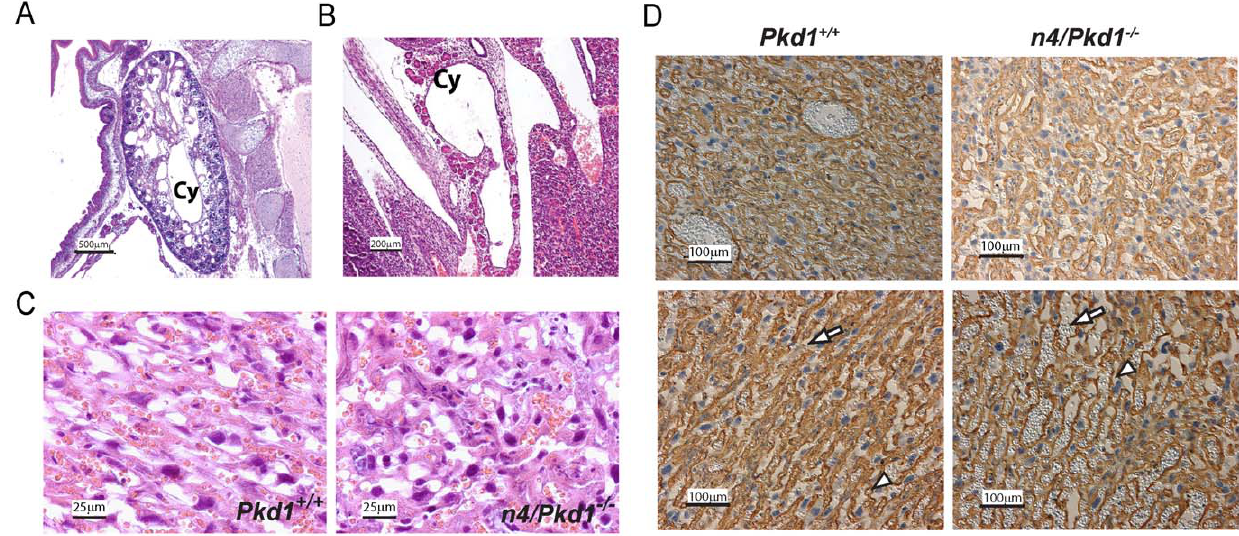
Figure 3. Placental Rescue by Tetraploid Aggregation. A, B. Haematoxylin-eosin stained sections of E17.5 tetraploid rescue n4/ Pkd1 2 / 2 embryos show classic Pkd1 null phenotype with renal cysts (Panel A) and pancreatic cysts (Panel B). This is because tetraploid wild type cells are not incorporated into the fetus. ‘‘Cy’’ denotes cysts. C. Haematoxylin-eosin stained placental sections harvested from viable E17.5 wild type ( Pkd1 + / + ) or Pkd1 mutant (n4/ Pkd1 2 / 2 ) embryos. The defect in the labyrinth layer appears improved in this placenta. D. IB4 staining of representative sections from E17.5 Pkd1 + / + (left panels) and n4/ Pkd1 2 / 2 placentas (right panels). There was variable improvement in the placental phenotype with the n4/ Pkd1 2 / 2 placenta in the upper panel appearing to be more like the wild type placenta.